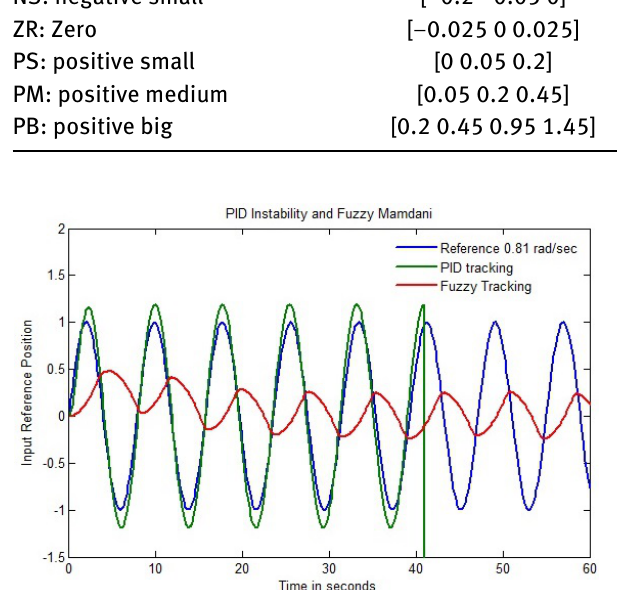
Figure 10: PID Instability and Fuzzy Mamdani.